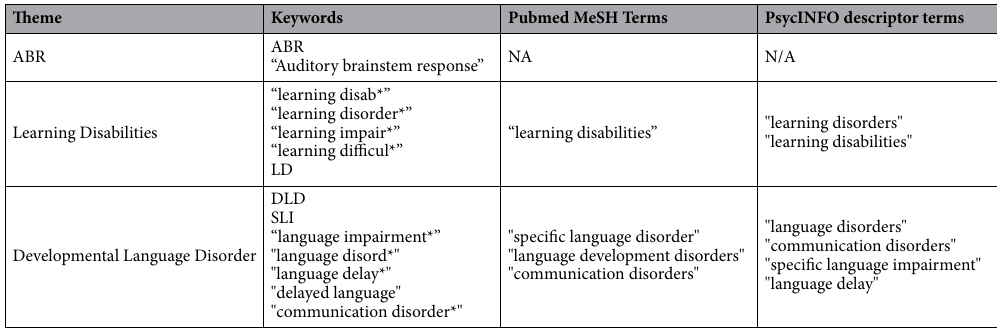
Table 2. Search terms used in the second search.